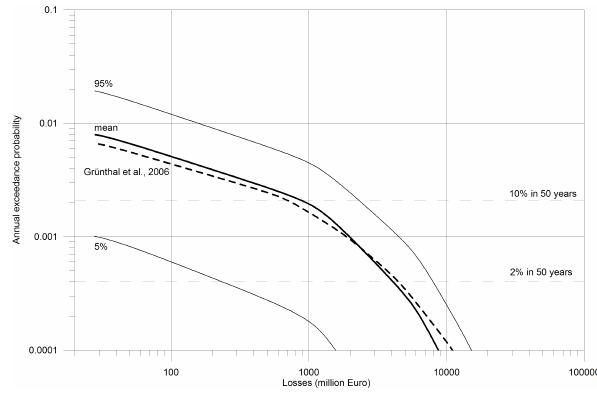
Figure 13. Seismic risk curves in terms of monetary losses (millions of Euros) due to structural damage to the residential building stock in Cologne (mean and 5–95% percentiles). The dashed line shows the mean risk curve from the study of Grünthal et al. (2006), which also included the damage to commercial and industrial buildings.